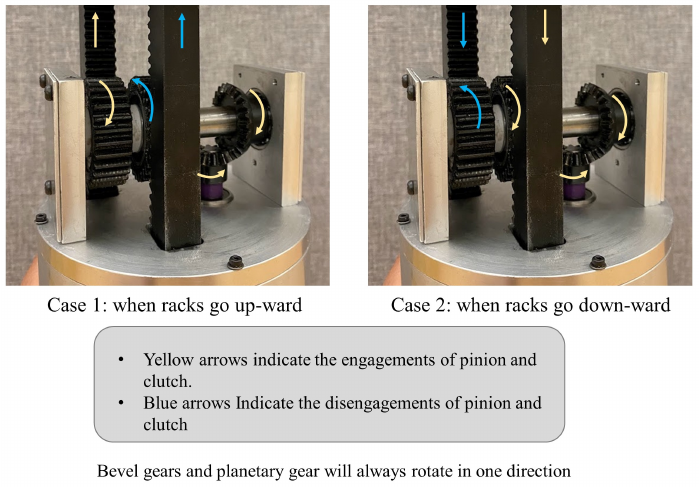
Figure 3. Schematic illustration of the transmission